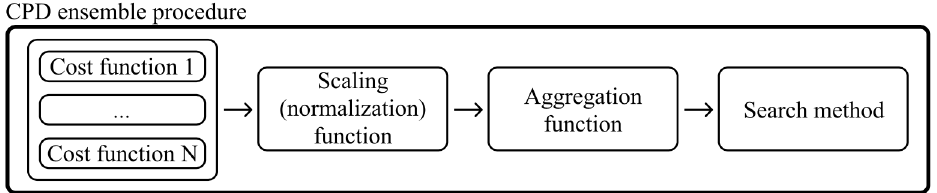
Figure 2. Components of a proposed CPD ensemble (CPDE)